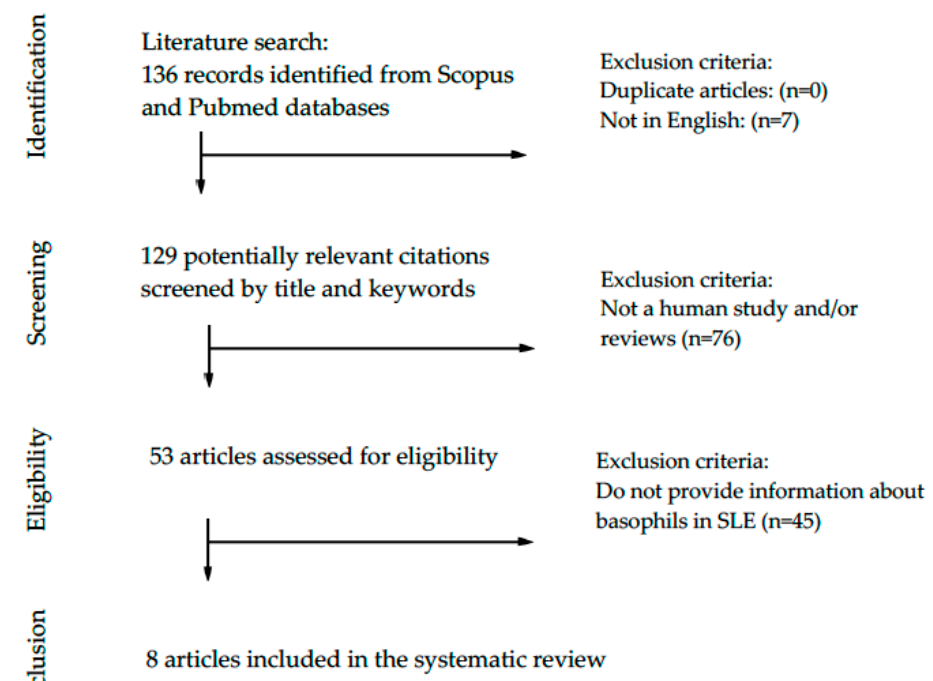
Figure 1. PRISMA flow diagram of the systematic literature search of studies investigating basophils in murine models of lupus.